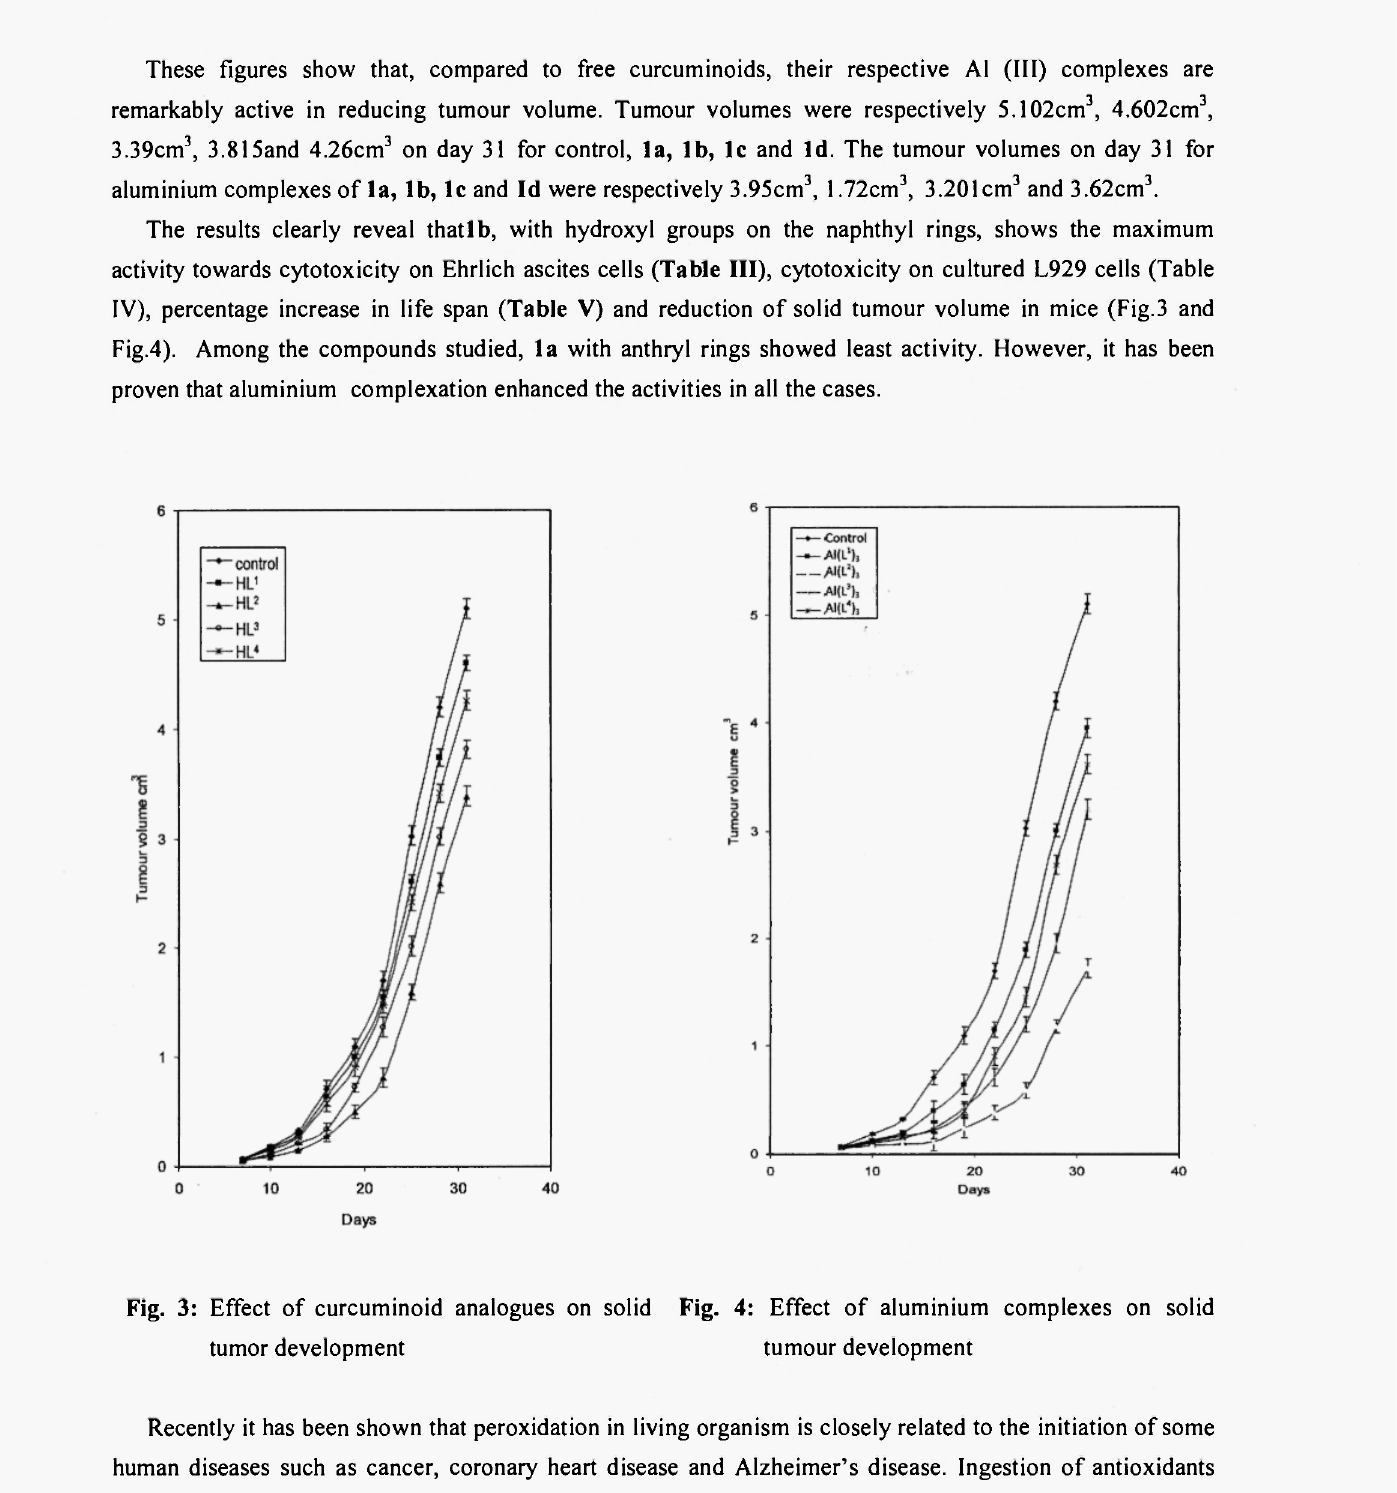
Fig. 3: Effect of curcuminoid analogues on solid Fig. 4: Effect of aluminium complexes on